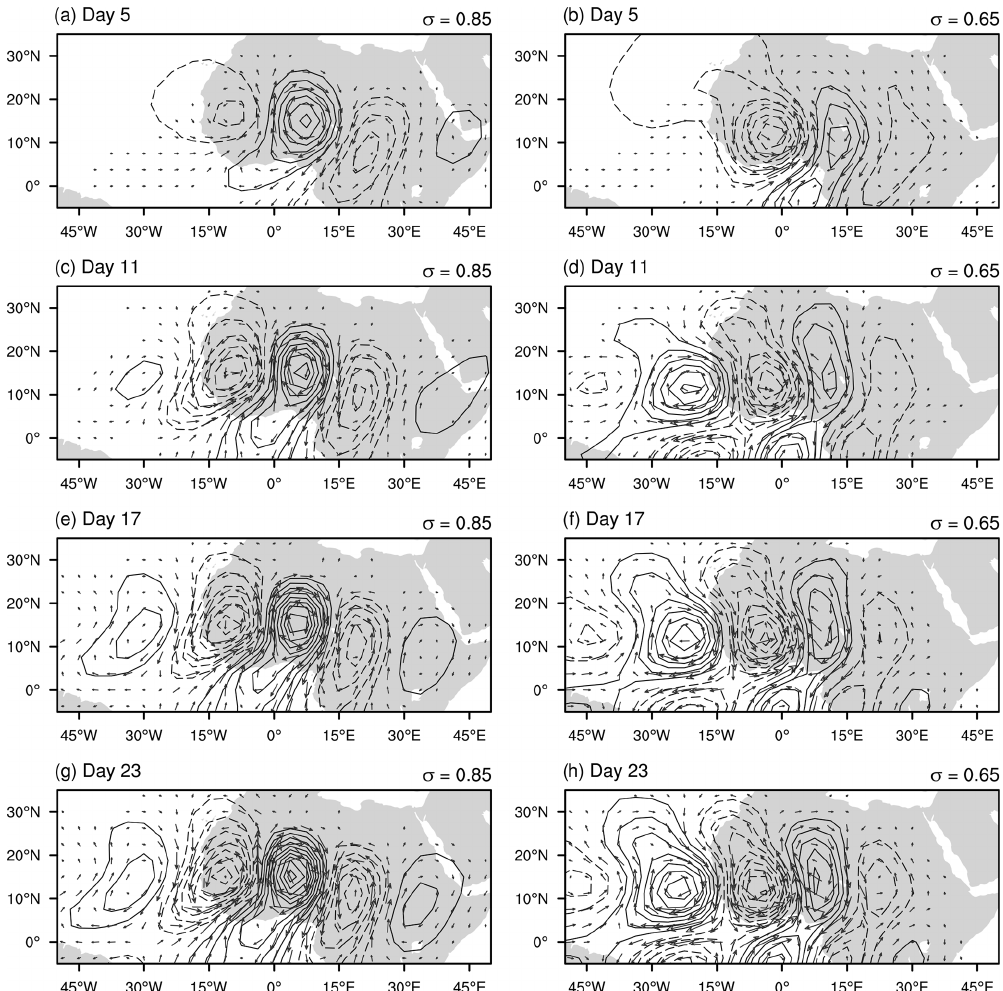
Figure 9. Streamfunction (interval 1 × 10 5 m 2 s − 1 with negative values dashed) and horizontal wind vectors at σ = 0 . 85 (a, c, e, g) and 0.65 (b, d, f, h) showing the wave response within the long-lived basic state for days 5, 11, 17, and 23 from top to